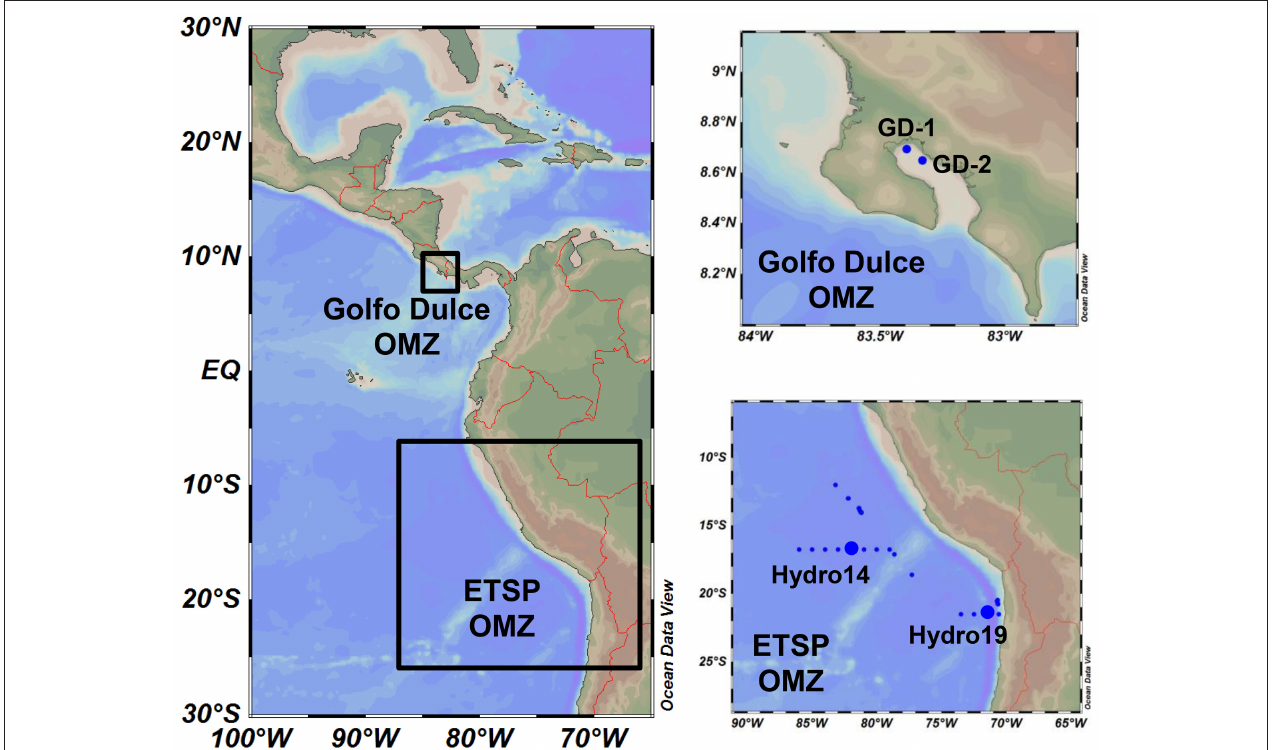
FIGURE 1 | Map of the study area and sampling stations. Study areas were located in the coastal Golfo Dulce (Costa Rica, January 2015) and the Eastern Tropical South Pacific (ETSP, July 2013), with four main sampling stations: GD-1 and GD-2 in Golfo Dulce and Hydro 14 and 19 off Chile and Peru.